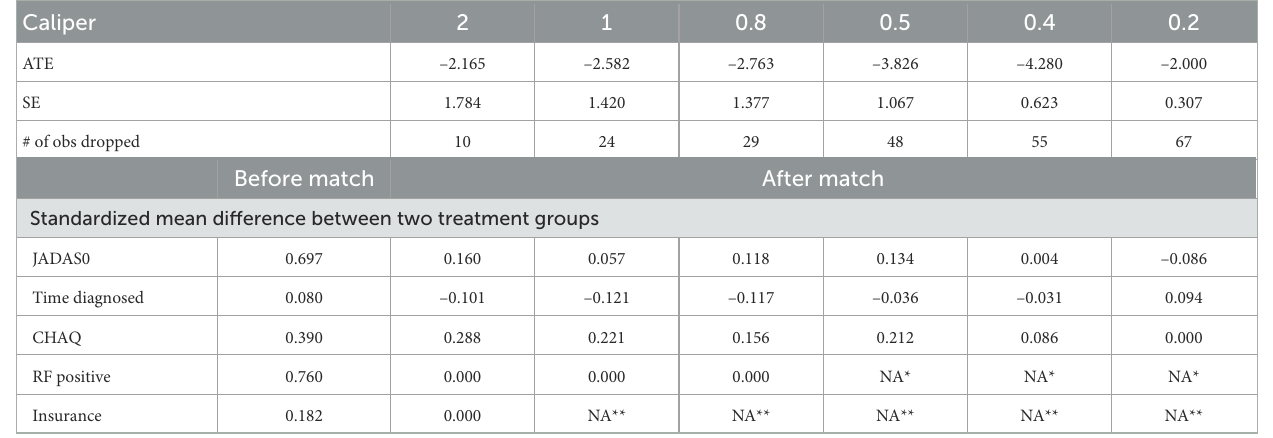
TABLE 5 Results of case study ATE estimates with matching method in case study. Caliper